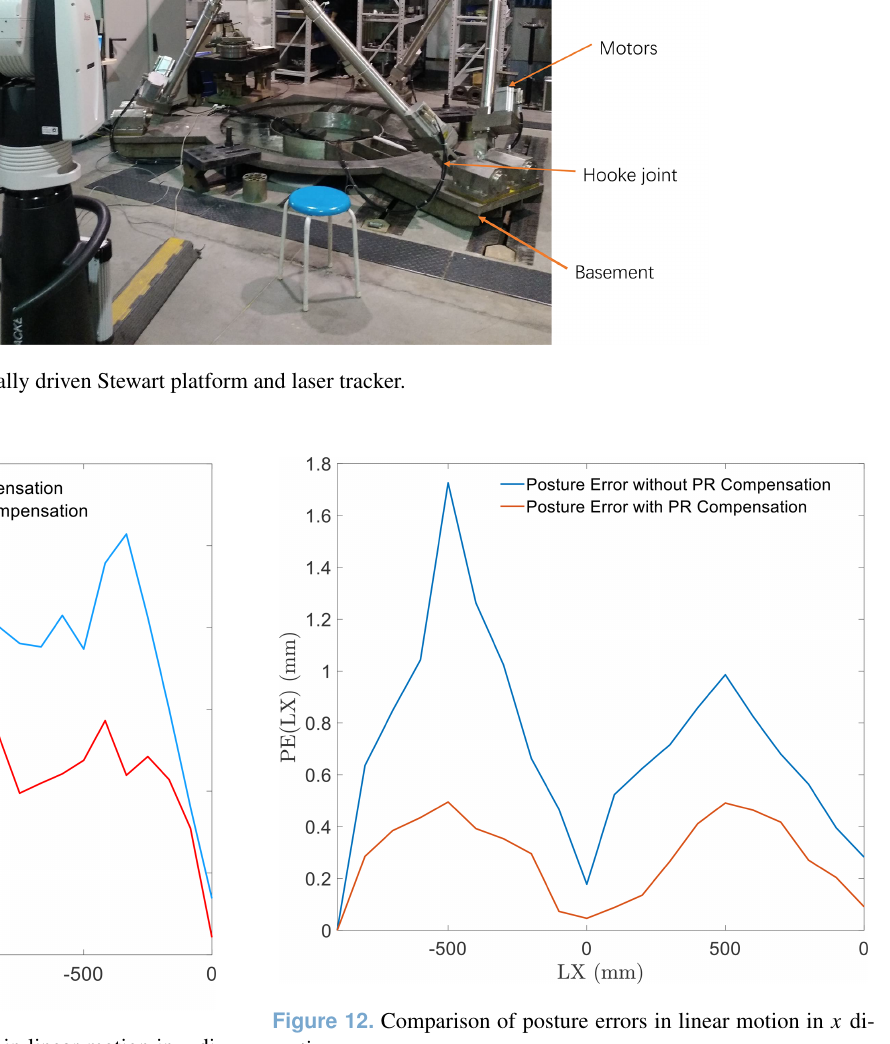
Figure 11. Comparison of posture errors in linear motion in z di- rection.